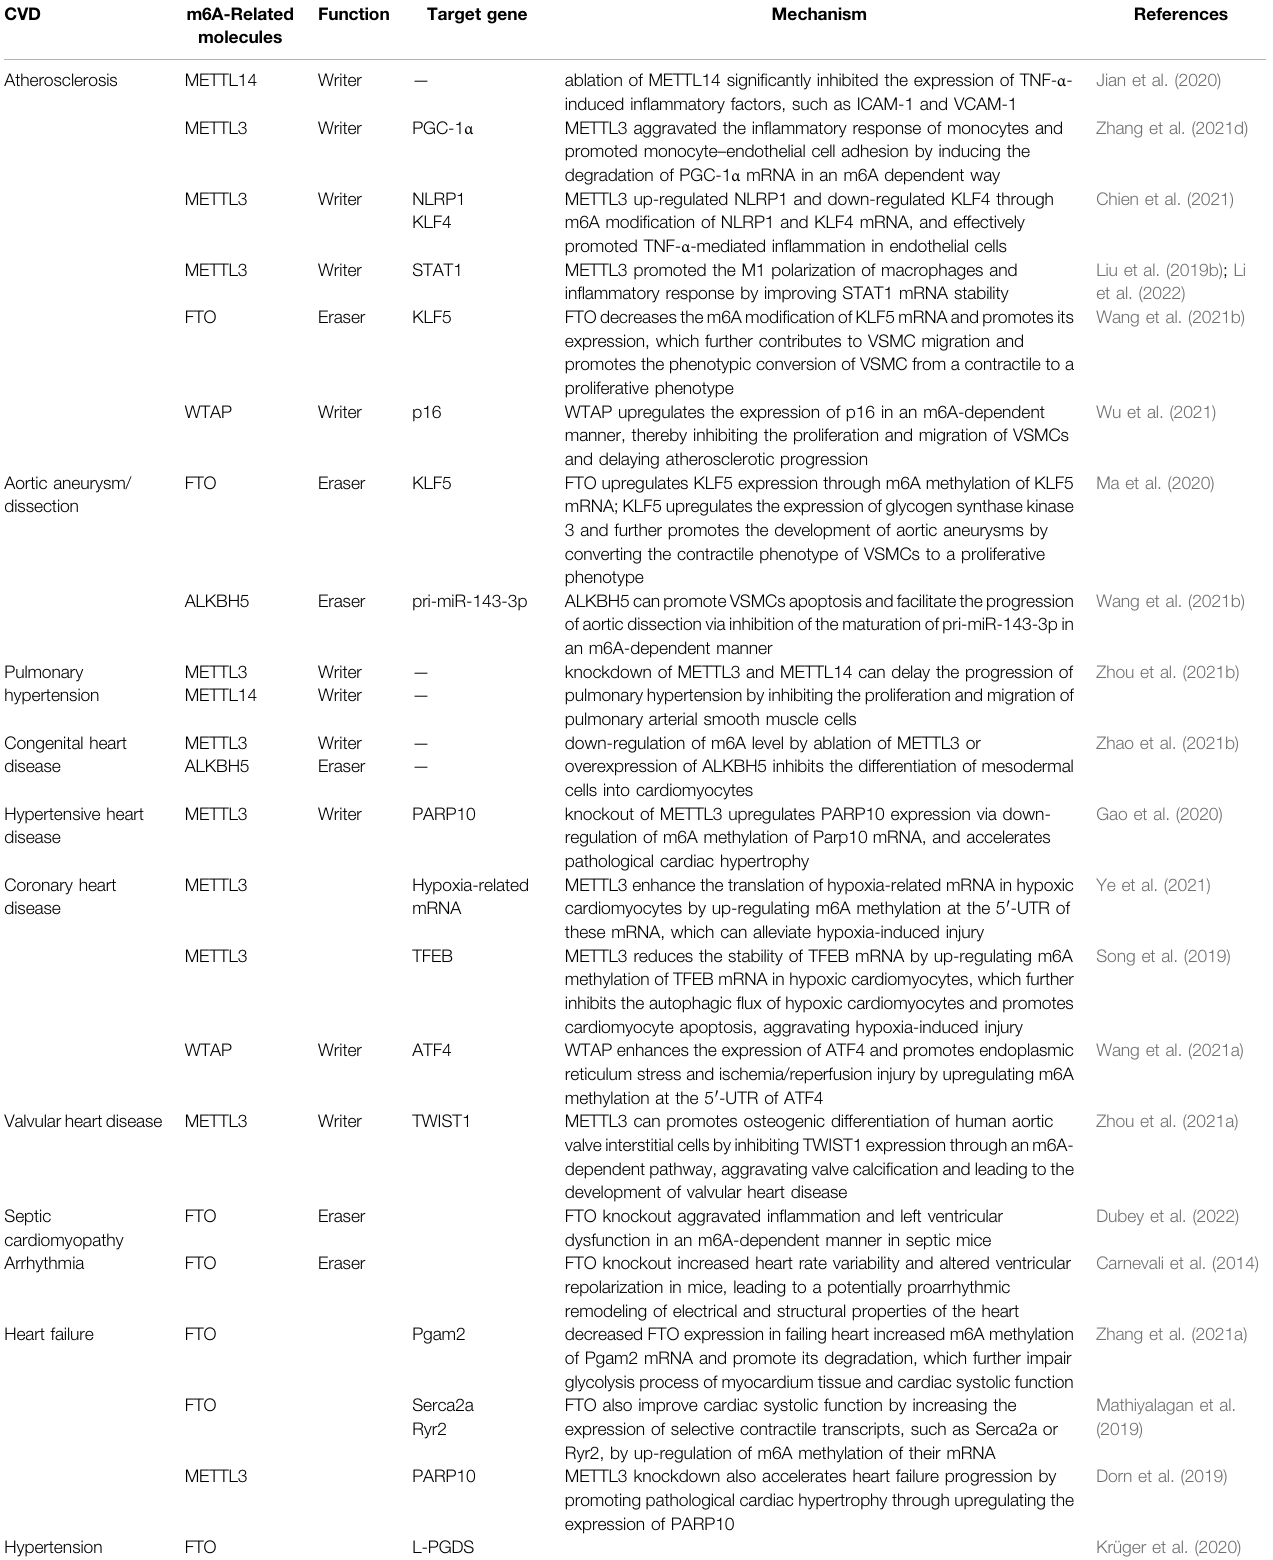
TABLE 3 | The role of m6A methylation in